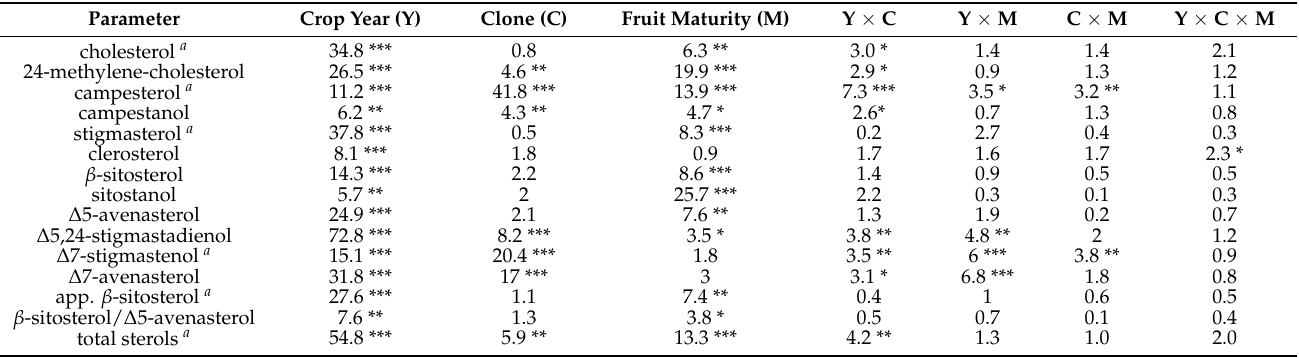
Table 2. Analysis of variance (F-values) by 3-way ANOVA of sterol composition in three crop years (Y) (2017, 2018, and 2019) on four Empeltre clones (C) (2, 3, 6, and Std) and in three fruit maturity stages (M) (green, spotted, and